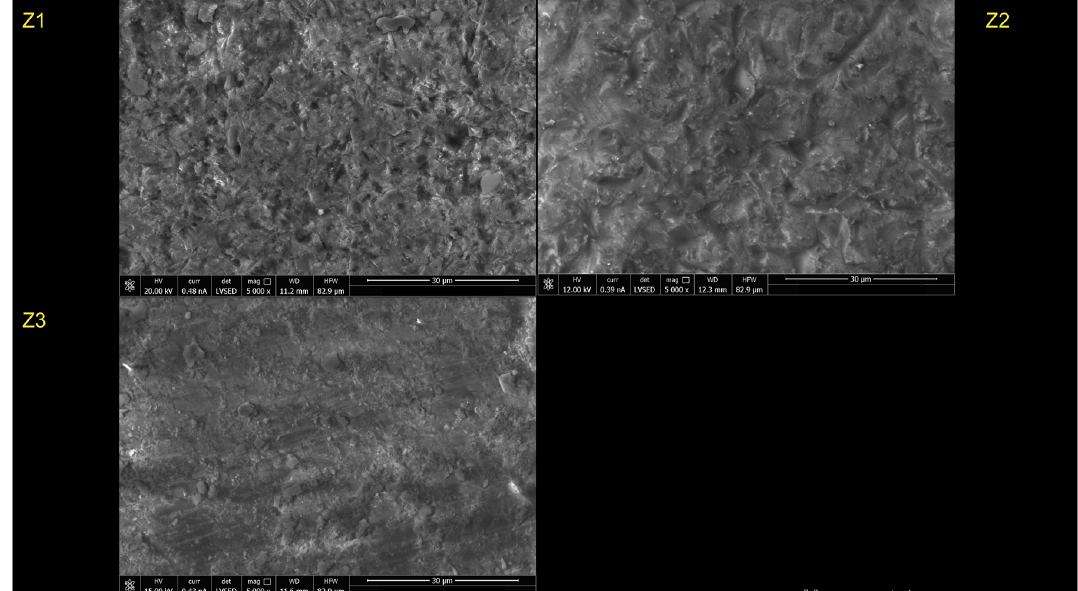
Figure 4. SEM analyses of zirconia crowns. SEM of the cameo surface of lithium disilicate at the 1st (Z1), 2nd (Z2), and 3rd (Z3).